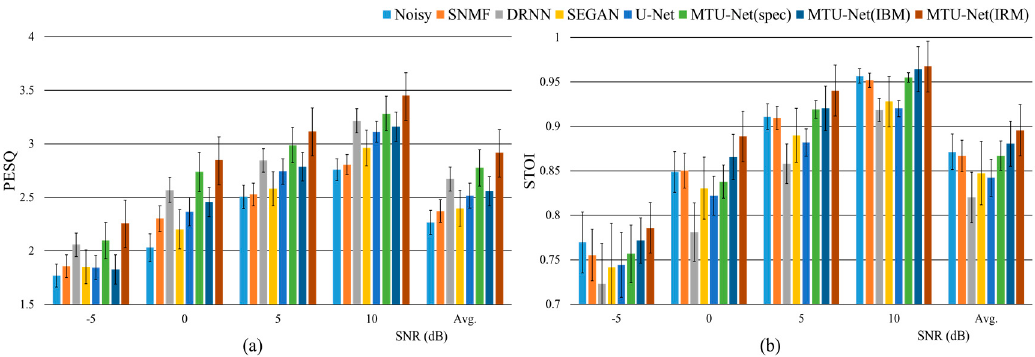
Figure 6. Comparison of the objective quality measures for seven different speech enhancement methods applied to the mismatched evaluation dataset: ( a ) perceptual evaluation of speech quality (PESQ) and ( b ) short-time objective intelligibility (STOI).